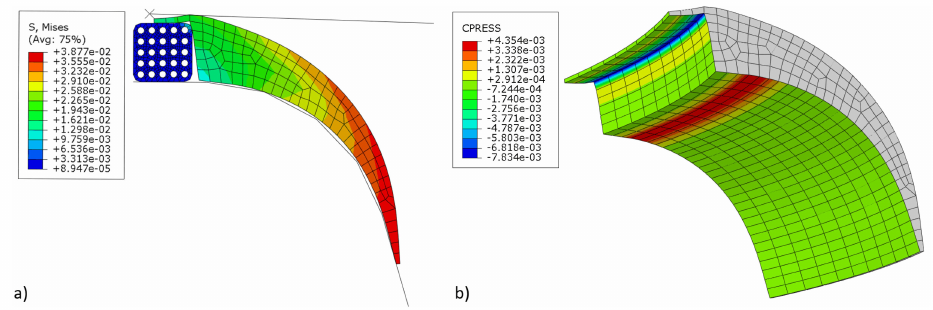
Figure 9. Simulation results before optimization: ( a ) von Mises stress (MPa); ( b ) contact pressure on the apex